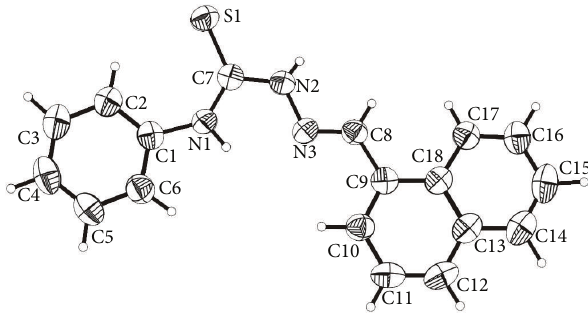
Figure 2: Molecular structure of HTSC 4 ( 4 ). The displacement ellipsoids are drawn at the 50%